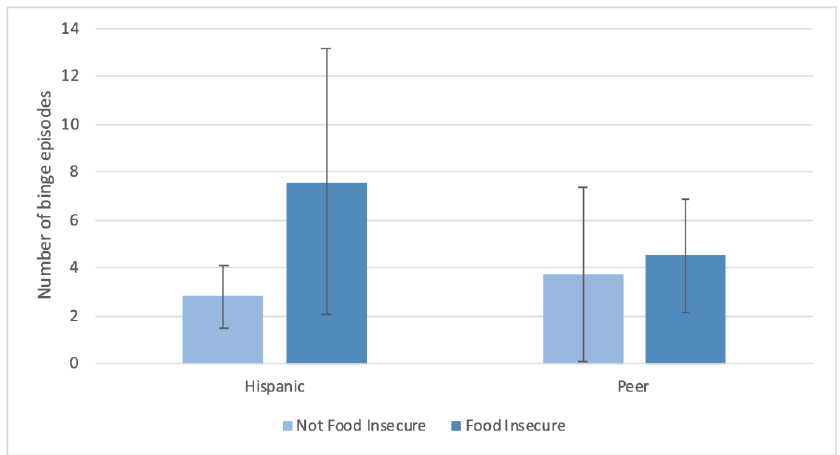
Figure 4. Count model of binge eating episodes among adolescents with at least 1 binge eating episode ( p = 0.02). Among Hispanic adolescents, p food insecurity < 0.001. Among peer adolescents, p food insecurity = 0.6. Mean ± SD are displayed. p food insecurity = 0.6. Mean ± SD are